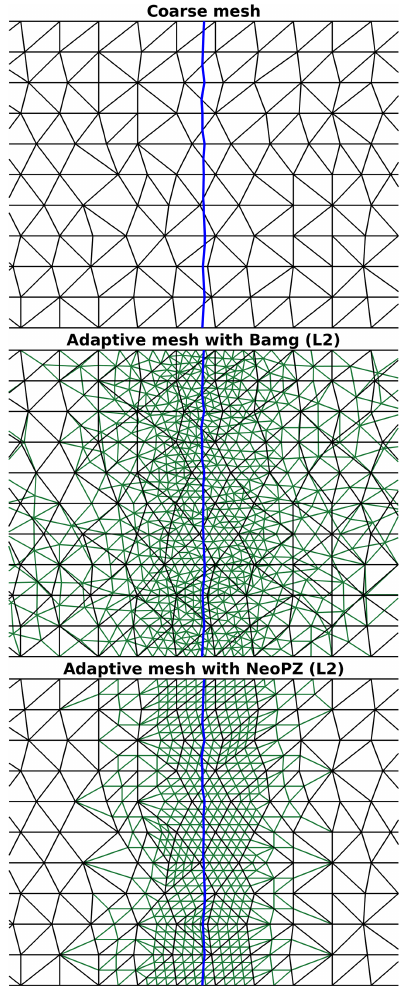
Figure 2. Examples of adaptive meshes using Bamg and NeoPZ. Blue line: grounding line position. Black lines: coarse mesh, com- mon for Bamg and NeoPZ. Green lines: adaptive meshes with level of refinement equal to 2 (L2). Bamg keeps vertices and connectiv- ities unchanged as much as possible compared to the coarse mesh. NeoPZ generates nested meshes; vertices and connectivities of the coarse mesh are kept